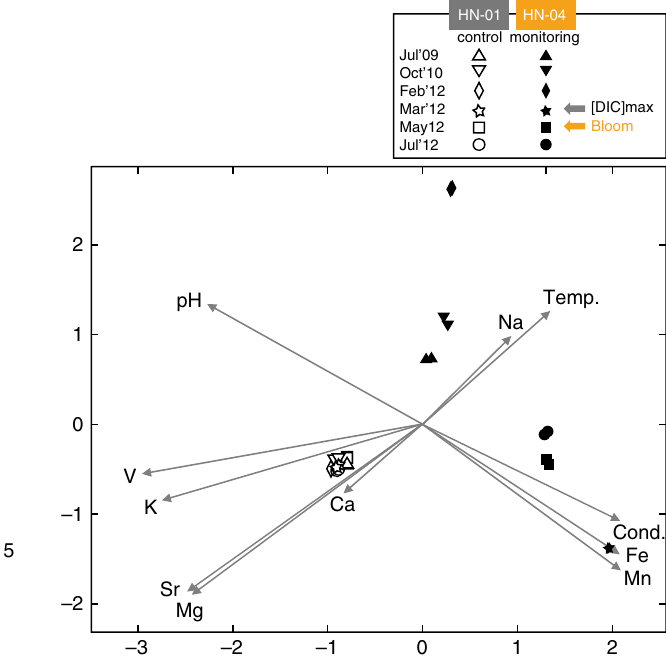
Fig. 5 Canonical correlations based on variance analysis all along the microbiological survey. The survey was carried out between July 2009 and July 2012. The represented geochemical parameters are variables (from Supplementary Tables 2 and 3) whose variance is correlated with the OTU relative abundances obtained from 454-pyrosequencing of 16S-rRNA amplicons (Figs. 2, 3, and Supplementary Fig. 5). The longer the arrow, the stronger the correlation. Monitoring well HN-04 features a strong correlation between Fe and Mn concentrations in groundwater and the OTUs retrieved in March 2012 (and to a lesser extend in May 2012 and